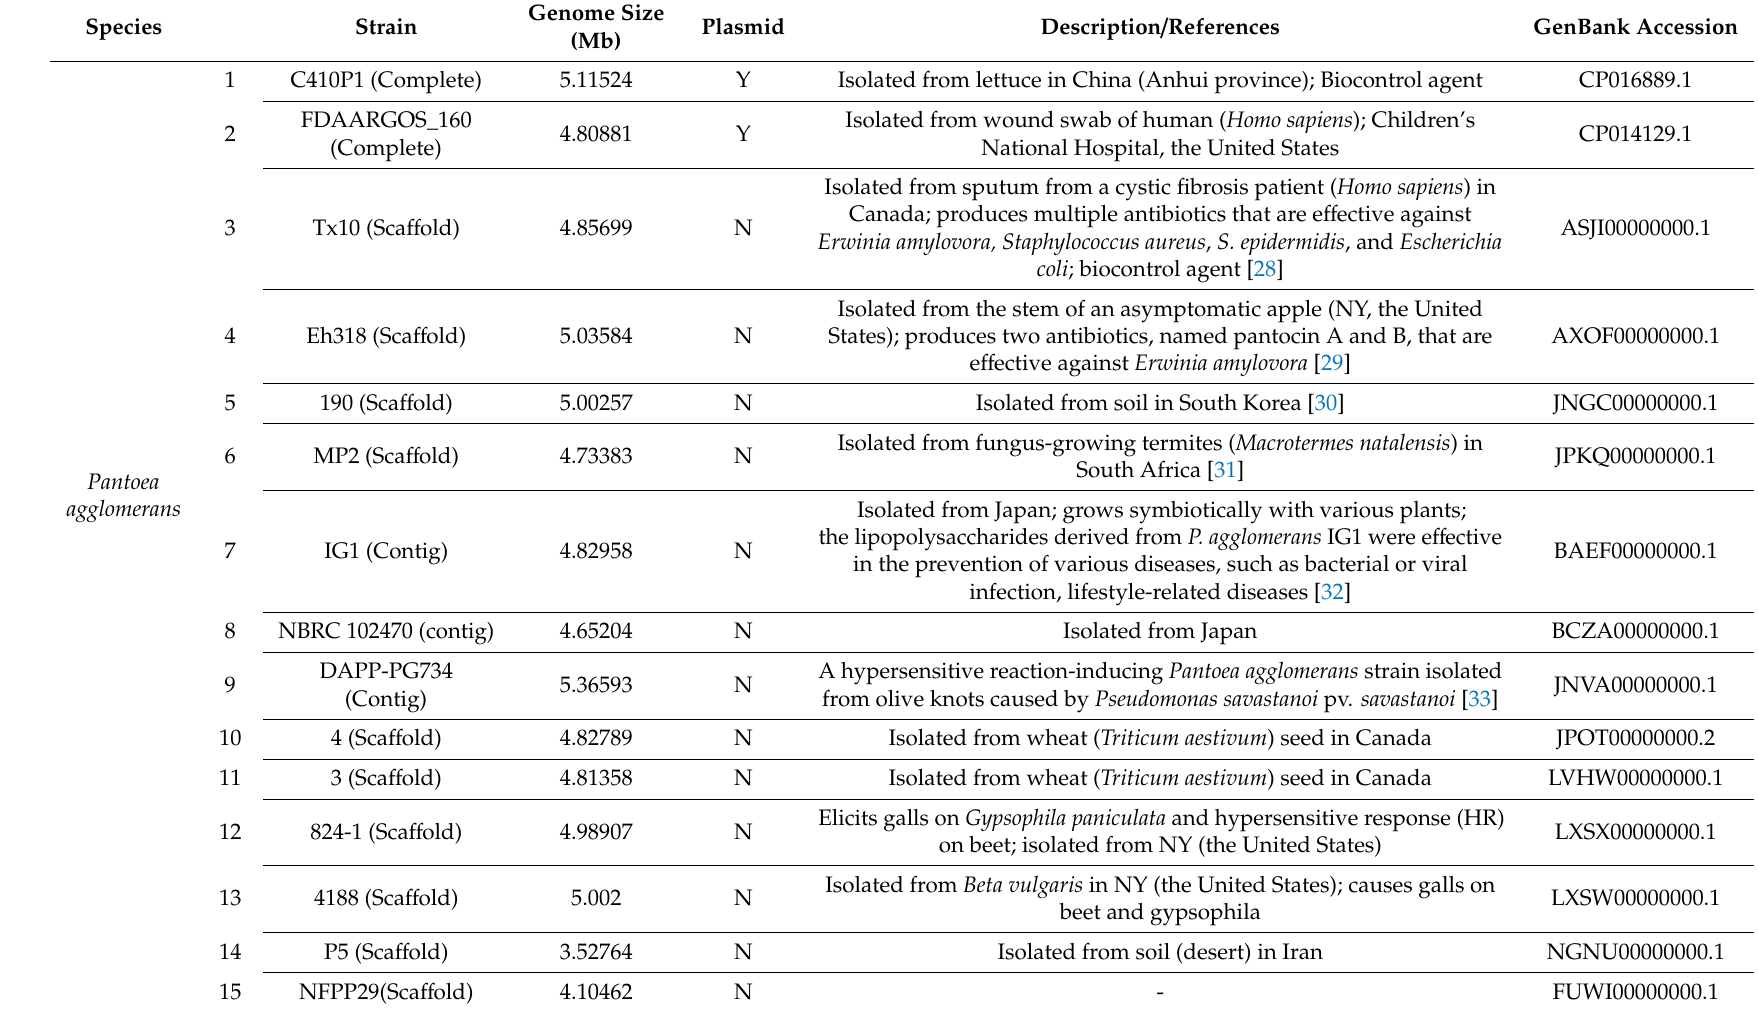
Table 1. List and characteristics of Pantoea strains used in the current